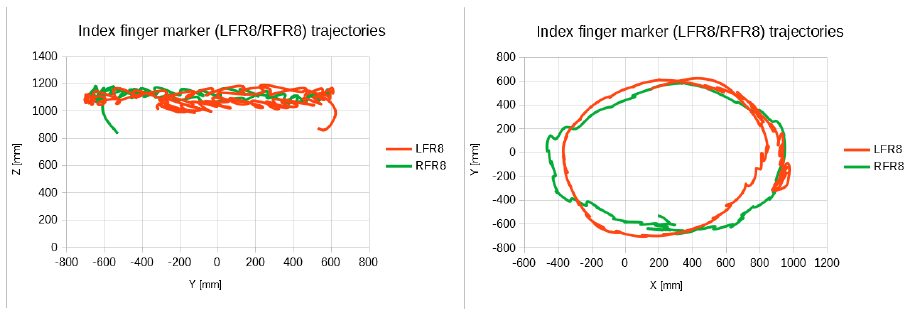
Figure 10. Trajectories for fingers for the second